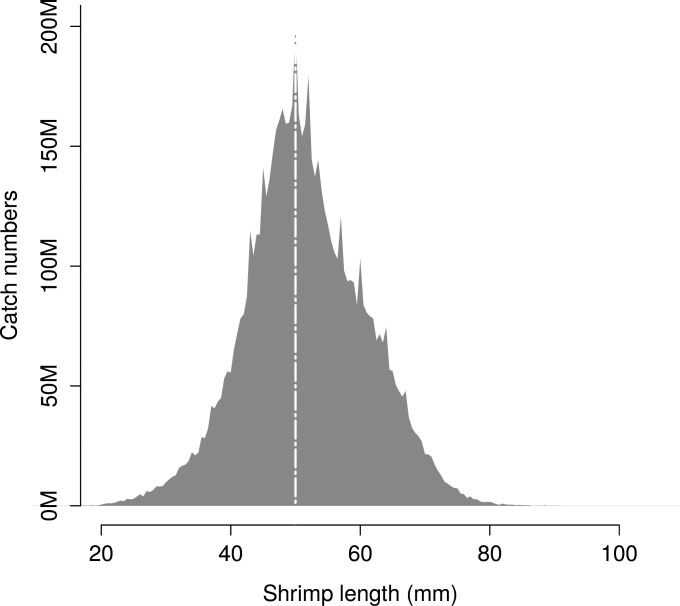
Size structure of the brown shrimp population fished during the sea trials.Numbers (in thousands, M) obtained after pooling the catches from the control codend over the experimental hauls.